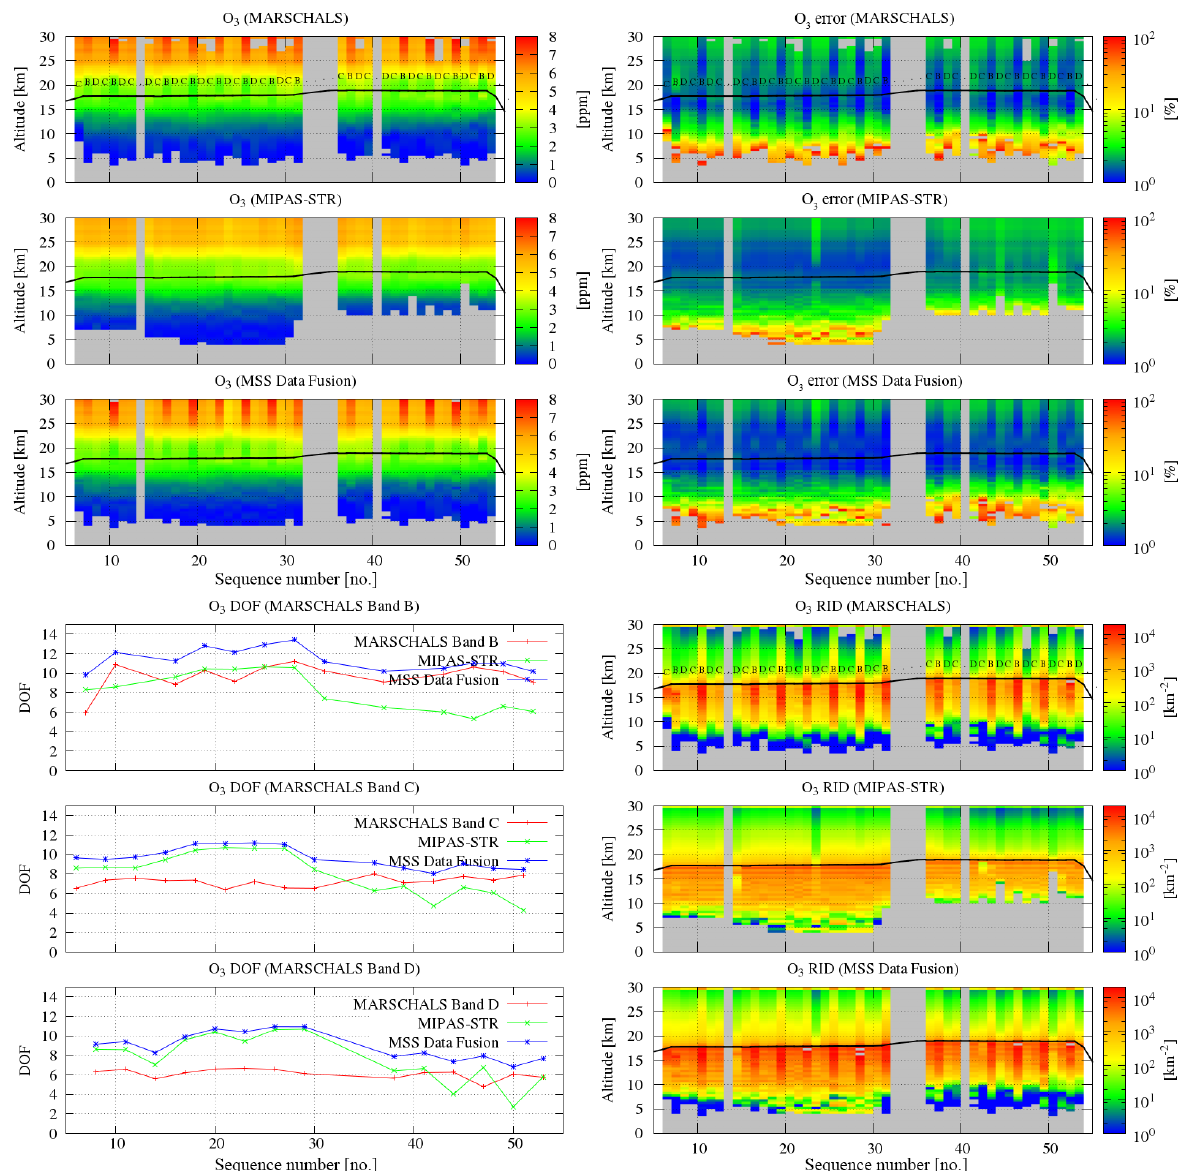
Figure 5. O 3 retrieved results obtained from MSS individual analysis and MSS data fusion of MARSCHALS and MIPAS-STR limb sounding observations: vertical profiles (top left panel), total relative error profiles (top right panel), number of DOF (bottom left panel) and RID profiles (bottom right panel). The black line across the maps in this figure, as well as in other figures of this paper, represents the flight altitude. The dotted and bold vertical lines marking the plot of the DOFs, in this figure, as well as in other figures of this paper, identify the border between leg 1 and leg 2 and between leg 2 and leg 3,